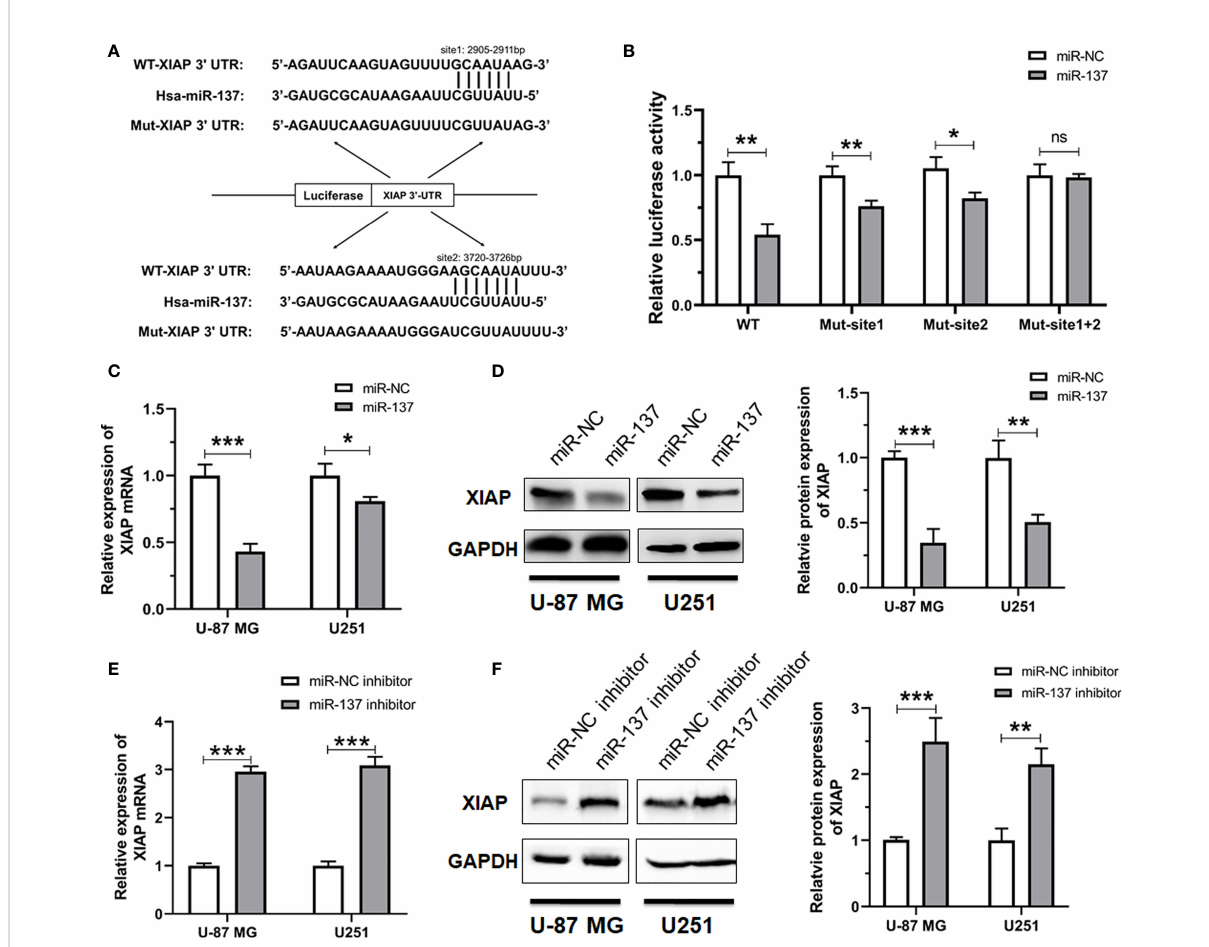
FIGURE 4 XIAP is a bona fi de target of miR-137 in GBM cells. (A) The potential binding sites of miR-137 to the 3 ’ UTR of human XIAP. The wild-type and mutant XIAP 3 ’ UTR were constructed into pGL3 vectors. (B) Relative luciferase activity analyses in HEK-293T cells co-transfected with Luciferase- XIAP 3 ’ UTR fusion and miR-NC/137. [The luciferase activity was examined 48 h after transfection. Data represents relative fi re fl y luciferase units from three separate experiments, and normalized to that of renilla luciferase]. (ns: not signi fi cant, *P < 0.05, **P < 0.01) (C) qRT-PCR analyses of XIAP mRNA, (D) Western blotting analyses of XIAP expression (left panel), the intensity analysis of western blotting (right panel) in U-87 MG/U251 cells transfected with the miR-NC/137. (E) qRT-PCR analyses of XIAP mRNA, (F) Western blotting analyses of XIAP expression in cells treated with the miR-NC or miR-137 inhibitor. [The analyses were performed 48 h after transfection. Data were exhibited as mean ± SD, n = 3. * P < 0.05, ** P < 0.01, *** P < 0.001 relative to